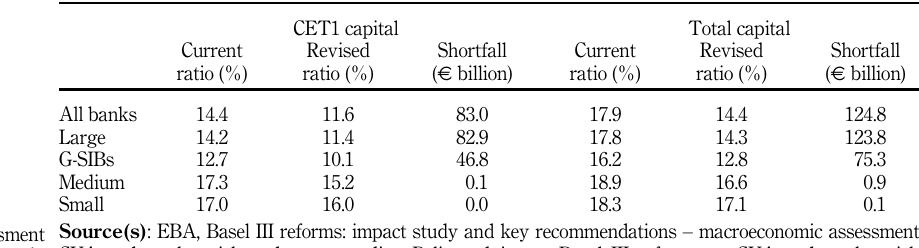
Table 10. The EBA ’ s assessment of the impact of Basel IV in the